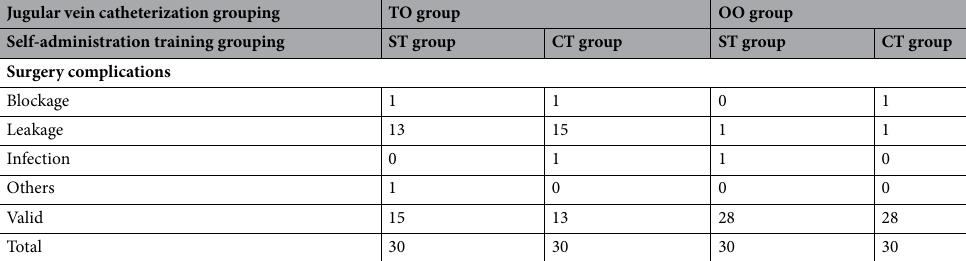
Table 1. Statistical results of the effect of jugular vein catheterization for rats in the Traditional Operation group and the Optimized Operation group. TO group Traditional operation group, OO group Optimized operation group, ST group Saline training group, CT group Cocaine training group.